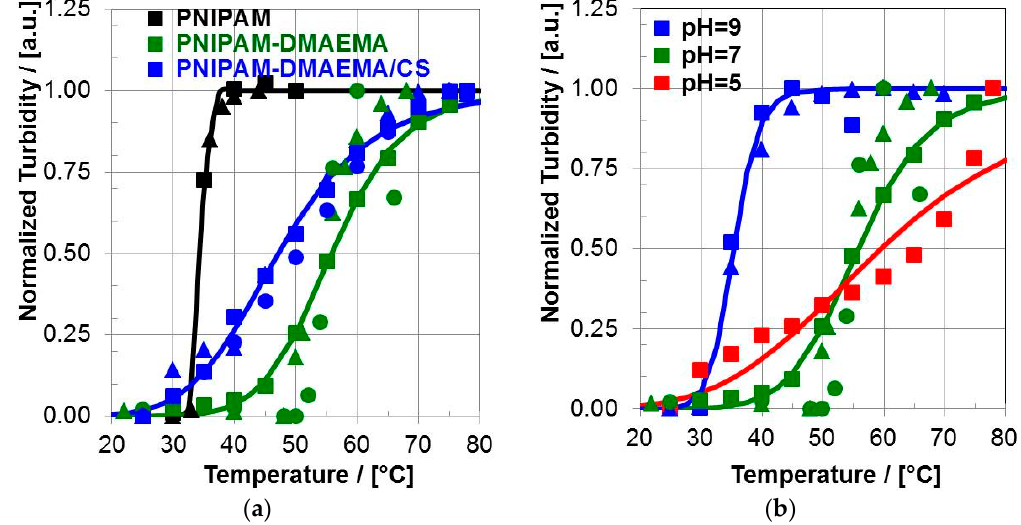
Figure 2. ( a ) Turbidity of PNIPAM (black) and PNIPAM-DMAEMA (green) solutions (0.02 M) compared to PNIPAM-DMAEMA/CS (0.01 M) dispersions (blue) for n − /n+ = 1.2 at pH = 7.0 as a function of temperature. (Cubes, triangles and circles denote different independent measurements, full lines correspond to fitted curves according to Equation (2)); ( b ) Turbidity of PNIPAM-DMAEMA solutions (0.02 M) at pH = 5.0 (red), pH = 7.0 (green) and pH = 9.0 (blue) as a function of temperature. (Cubes, triangles and circles denote different independent measurements, full lines correspond to fitted curves according to Equation (2)).